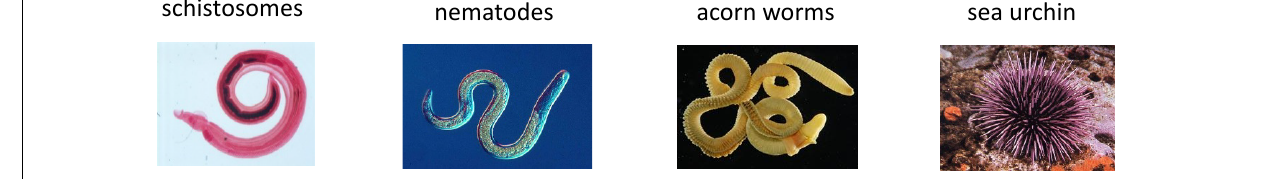
FIGURE 8 | Illustration of the distribution of HFS site sequences in NALCN, sodium channels (Na v 2 and Na v 1) and calcium channels (Ca v 1, Ca v 2, and Ca v 3) in different animals groups, as well as single cell eukaryotes Thecamonas (apusozoan) and Salpingoeca (choanoflagellate) (Top panel). Illustrations of animals (images imported from Wikipedia) lacking Na v 1 channel genes (Bottom panel). Lifeforms with calcium-selective pores (shaded orange color) include HFS site sequences mostly of negatively charged glutamate (E) or aspartate (D) residues: DEEA, DEES, DEEG, DEET, EEEE, EDEE, NEEE, while sodium-selective pores (shaded blue color) have a lysine (K) residue in Domains II (EKEE and DKEA) or a lysine residue in Domain III (EEKE, DEKA, and DEKG). Ca v 3 T-type calcium channels have a selectivity filter of EEDD and may be calcium or non-selective channels (shaded orange color), with high sodium selectivity engendered in invertebrate Ca v 3 channels by alternative splicing of exon 12a coding for a novel L5 II turret (shaded blue color). Greater sodium selectivity also involves a D4L6i extracellular turret found in invertebrates instead of the D4L6v turret found in cnidarians and vertebrates. Numbers in brackets next to the gene indicate the number of gene isoforms (2, 3, 4, 5, or 10) that have been identified in a species, outside of one. An () indicates loss of gene in the indicated species. Amino acid sequences were aligned using MUSCLE 3.7 (Edgar, 2004) within EMBL-EBI web interface (Chojnacki et al., 2017).